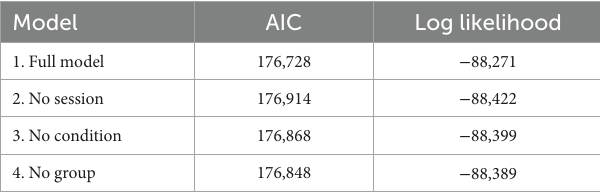
AIC, Akaike information